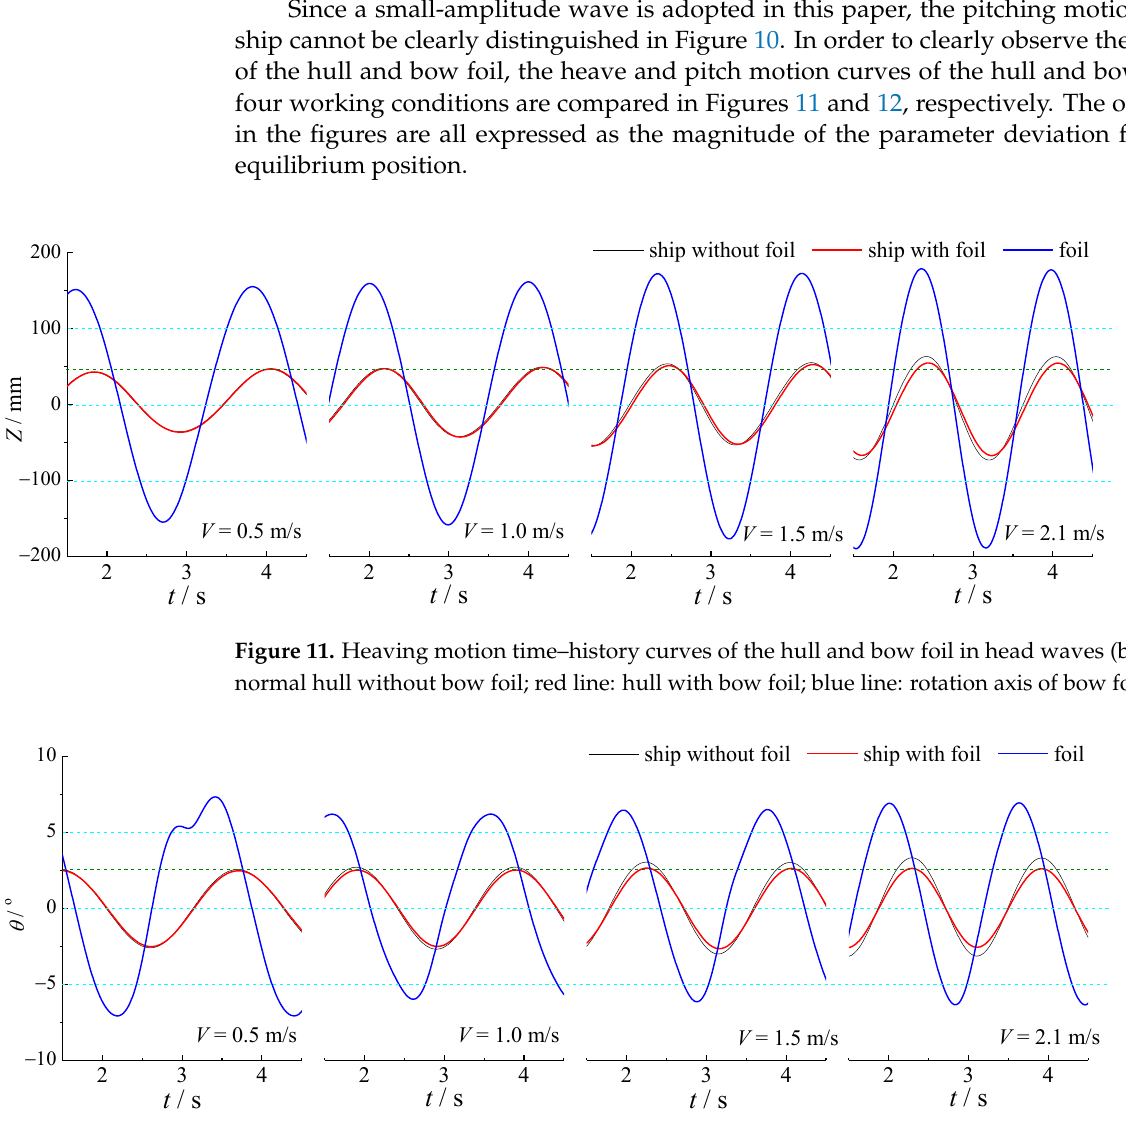
Figure 12. Pitching motion time – history curves of the hull and bow foil in head waves (black line: normal hull without bow foil; red line: hull with bow foil; blue line: rotation axis of bow foil).